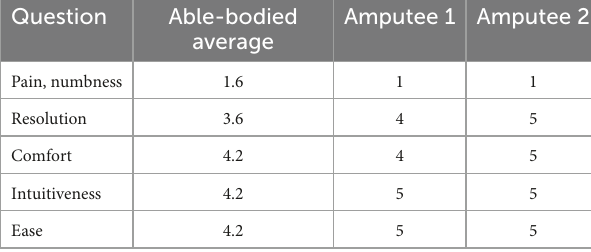
TABLE 1 Results of the